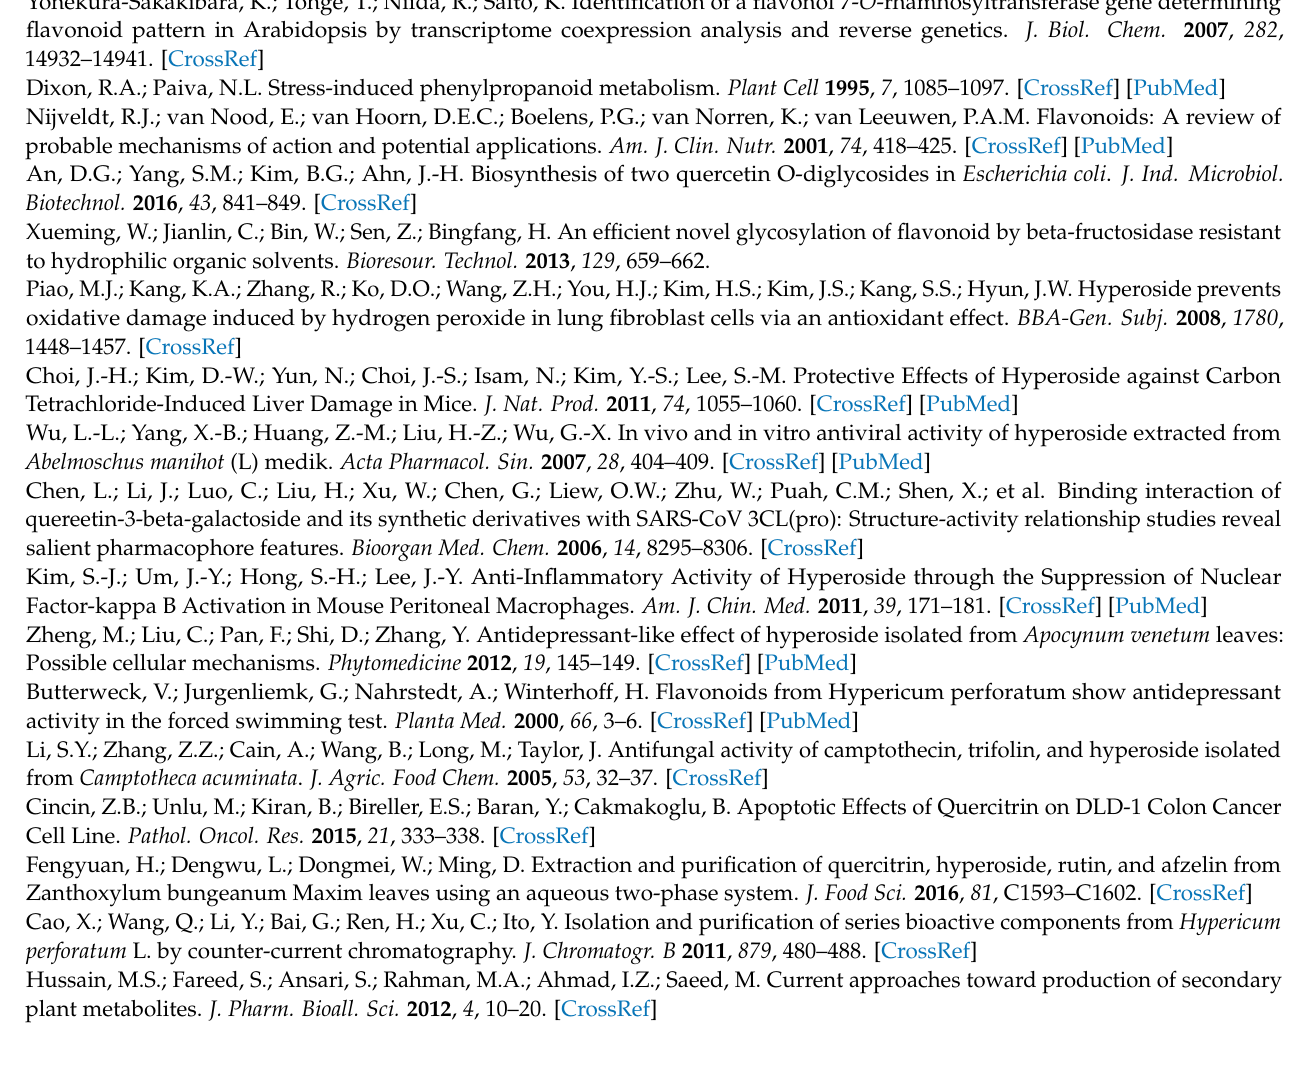
Figure S3: 13 C NMR spectra of purified hyperoside; Table S1: Primers used in the present